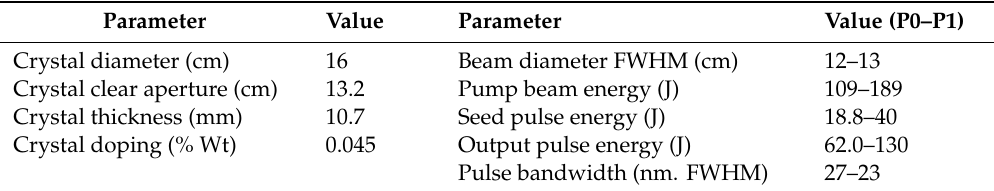
Table 2. Main design and operational parameter for the amplifier AMP3 in the reflection configuration.